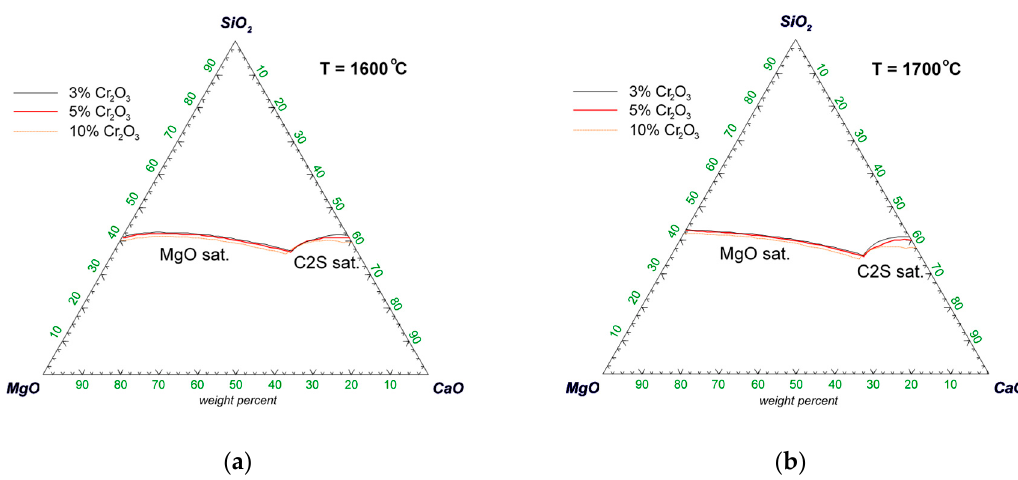
Figure 3. Calculated MgO and C 2 S saturation lines of the CaO-MgO-SiO 2 -5% Al 2 O 3 -Cr 2 O 3 system with 3% to 10% Cr 2 O 3 at P(O 2 ) = 10 − 9 atm. (a) T = 1600 °C and (b) 1700 °C.